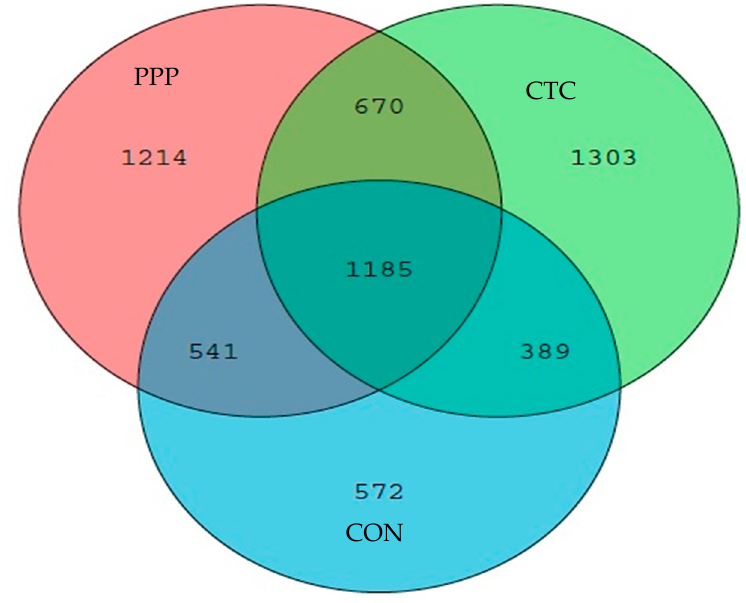
Figure 1. Dietary pomelo peel powder affected ileum morphology in weaned piglets.